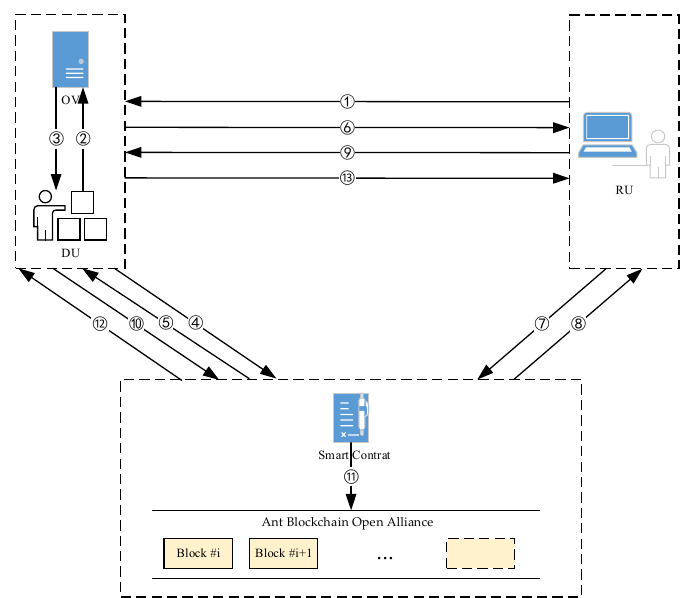
Figure 7. Zero watermarking storage process.